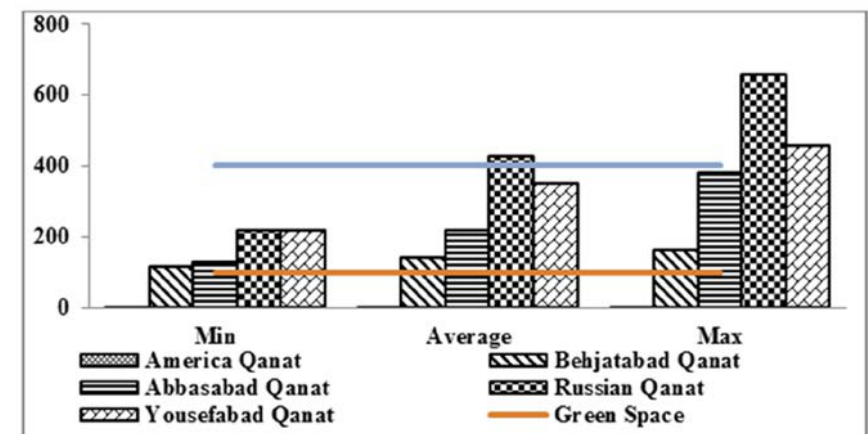
(Qanats)Fig.14: Measured fecal coliforms of the studied aqueducts Fig.14: Measured fecal coliforms of the studied aqueducts (Qanats)